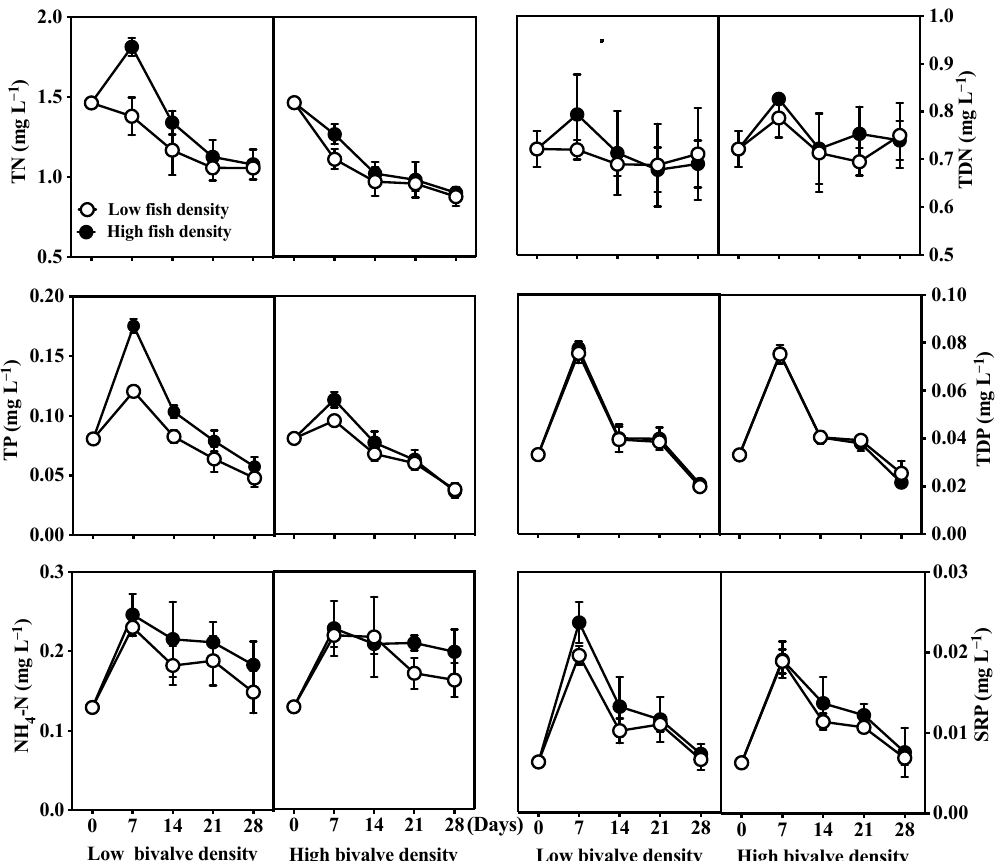
Figure 3. Time series of TN, TP, TDN, TDP, NH 4 -N and SRP in the different treatments during the experiment (means ± standard deviation (SD)).